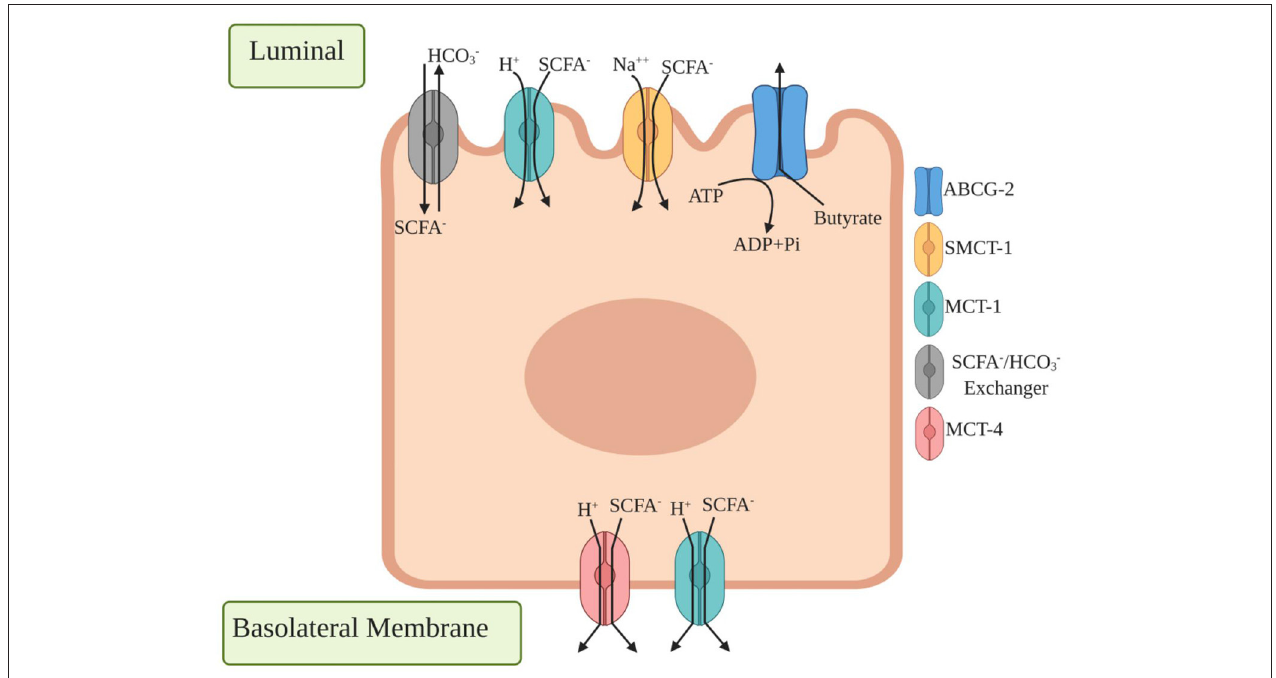
FIGURE 3 | Different transporter proteins expressed in colonic epithelium cells for transport of short chain fatty acids (SCFA). Luminal side expressed transporters are HCO − 3 /SCFA − exchangers which secrete HCO − 3 that result in SCFA − transport across the apical membrane, monocarboxylate transporter 1 (MCT1) binds a proton first followed by monocarboxylates such as lactate, pyruvate, and transport to the cell where basolateral side expressed monocarboxylate transporter 4 (MCT4) functions similarly by exporting SCFA − from the basolateral membrane. ATP binding cassette transporters G family Member 2 (ABCG2) is expressed in apical colonic cells where they bind with butyrate as a substrate for efflux in intestinal